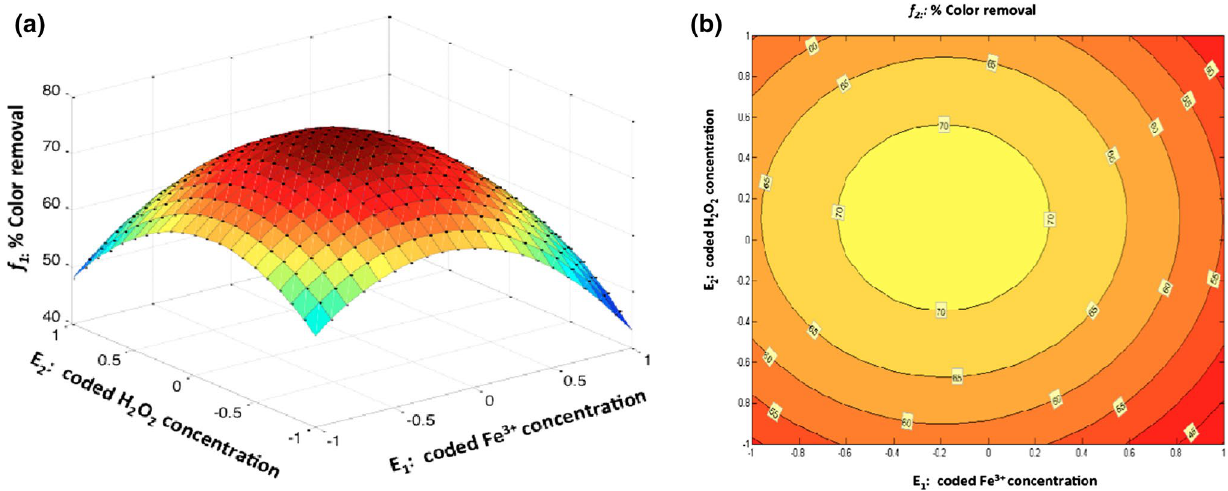
Fig. 3 Plots of colour removal response with respect to Fe 3+ dose and H